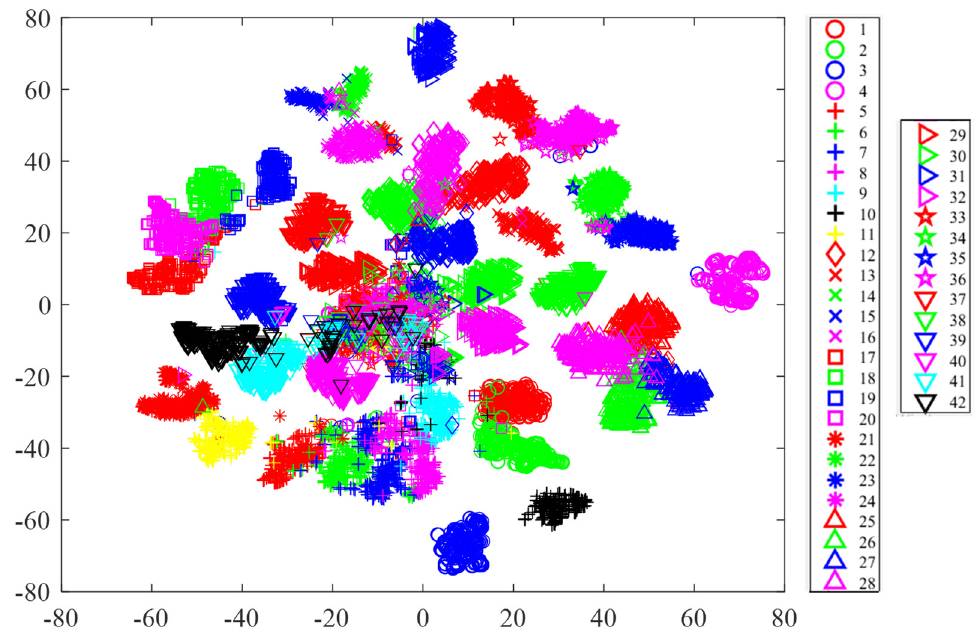
Figure 12. Visualization of the activations from layer “pool5” of ResNet18 on original data via PCA and t-SNE. (1: normal; 2–8: unbalance with (6, 10, 15, 20, 25, 30, 35) g mass; 9–12: horizontal misalignment of (0.5, 1, 1.5, 2) mm; 13–18: vertical misalignment of (0.51, 0.63, 1.27, 1.4, 1.78, 1.9) mm; 19–22: overhung position ball fault with (0, 6, 20, 35) g unbalance; 23–26: overhung position cage fault with (0, 6, 20, 35) g unbalance; 27–30: overhung position outer race fault with (0, 6, 20, 35) g unbalance; 31–34: underhung position ball fault with (0, 6, 20, 35) g unbalance; 35–38: underhung position cage fault with (0, 6, 20, 35) g unbalance; 39–42: underhung position outer race fault with (0, 6, 20, 35) g unbalance). (Refer to online color